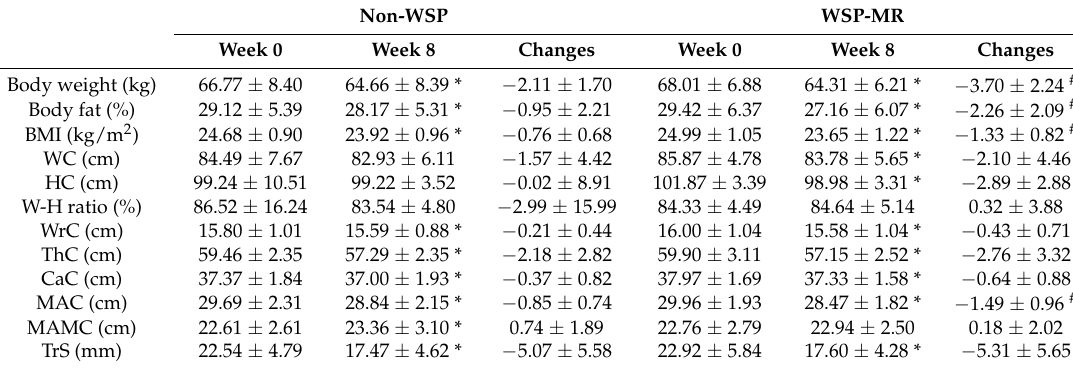
Table 3. Changes in participants’ anthropometric parameters over weeks